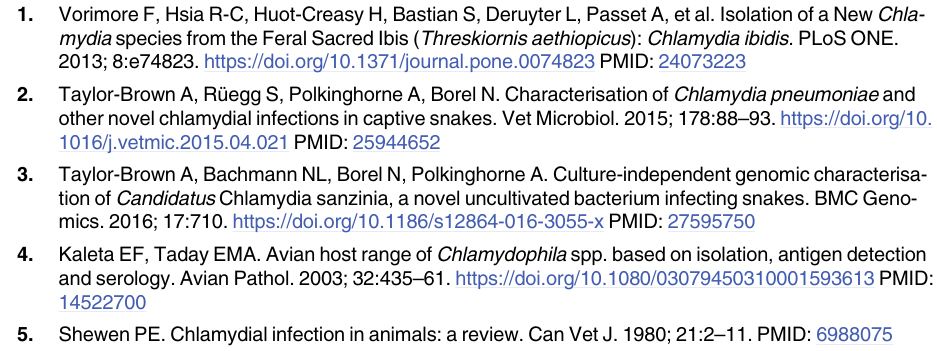
S3 Table. Percentage of Chlamydia DNA out of total DNA ( Chlamydia -%) from paired swab and liver samples. S4 Table. Results for MLST analysis and omp A genotyping for the 12 selected C . psittaci